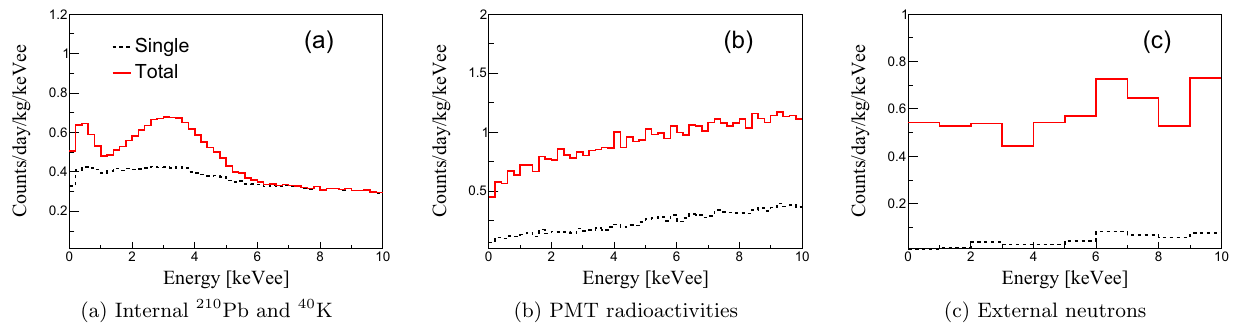
Fig. 4 Simulated energy spectra of the NEON crystal in 0–10keV energy region from different background sources for the total events (solid-red lines) and single crystal hit events (black-dashed lines) that have no hit in the LS and other crystals. a Internal 210 Pb and 40 K assum- ing the NEO-5 contaminations in Table 1 are generated. b The PMT